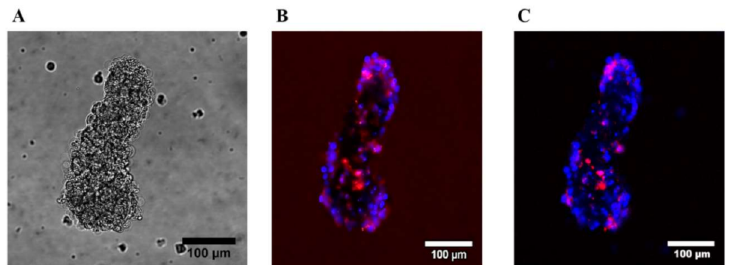
Figure 5. Representation of a multicellular HUVEC aggregate after 24 h (S-24h) under nonadherent conditions. ( A ) Visualized by phase contrast microscopy. ( B ) Same HUVEC aggregate illustrated by cLSM labelled with Annexin-V/Alexa647 for apoptotic (red) and DAPI for dead cells (blue) as overlay of all 60 stacks using maximum projection mode. ( C ) Centre stack of the same HUVEC aggregate illustrated by